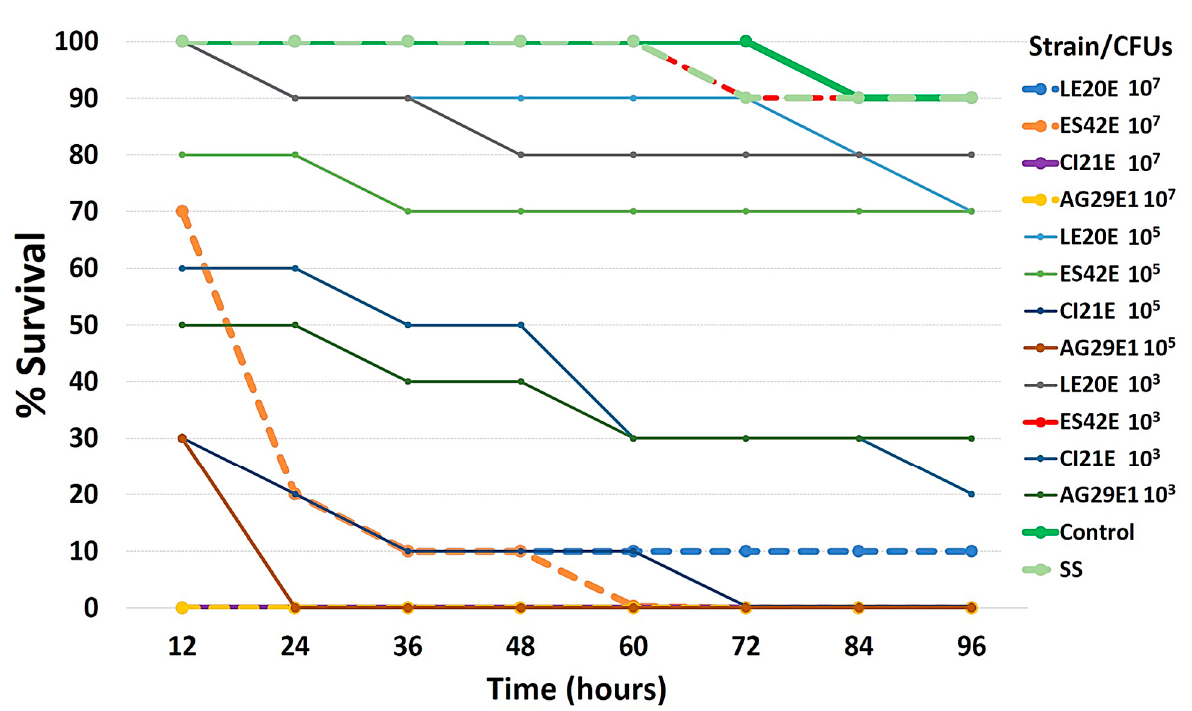
Figure 4. Survival rate of worms after challenge with four Aeromonas strains, two non-cytotoxic (LE20E and ES42E) and two cytotoxic (CI21E and AG29E1). Ten larvae were infected with saline alone, with 10 3 , 10 5 , or 10 7 CFUs of each strain, or uninoculated (no manipulation control), incubated at 37 ˚ C for 96 h. The time of the death of the larvae was recorded. Results are the mean of three independent experiments.